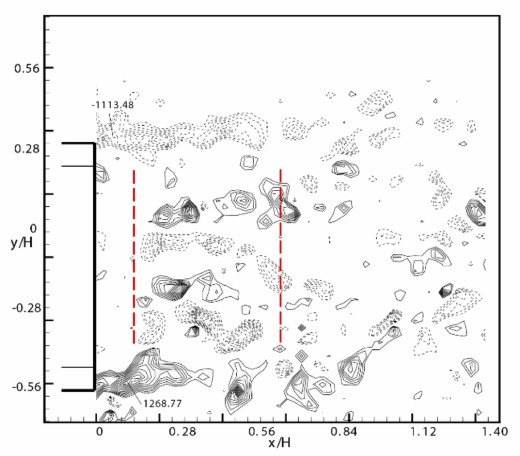
Figure 23. Iso-contours of instantaneous streamwise vorticity, ω z in x–y plane at z/H = − 0.08. Minimum and incremental values of vorticity are ω z,min = − 478.213 s − 1 , 474.689 s − 1 , and − 1 , respectively. ∆ ω z = 190.581 s